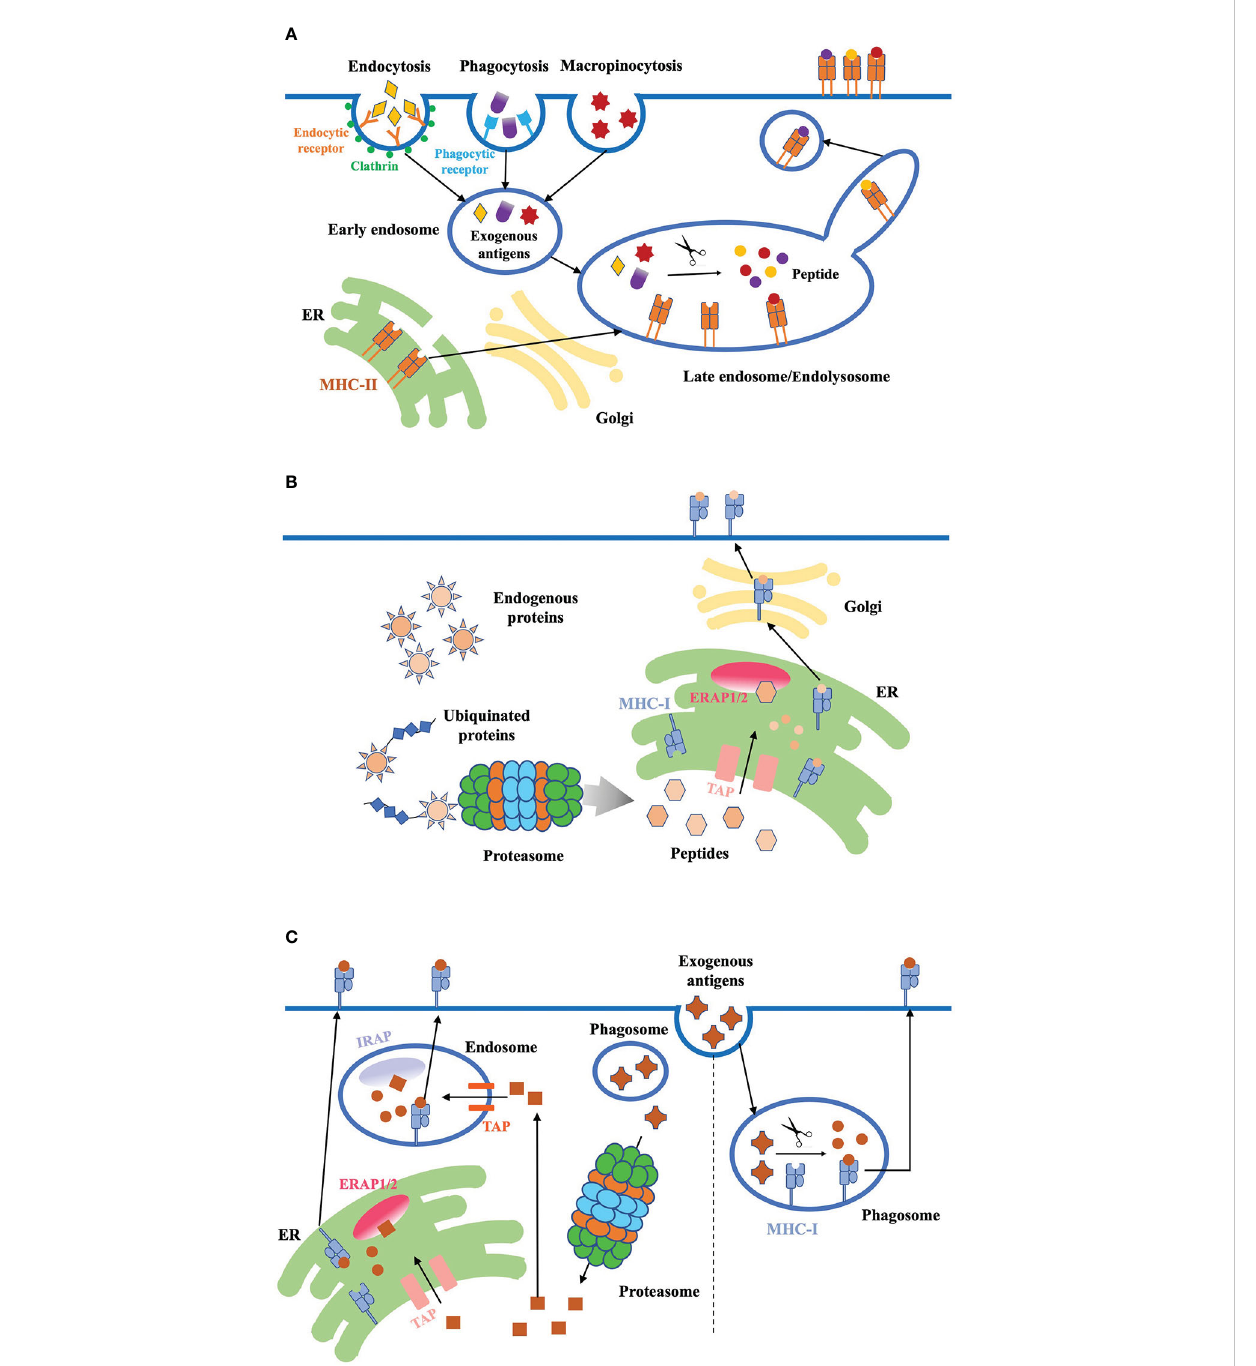
FIGURE 2 Antigen internalization, processing and presentation. (A) Exogenous proteins. DCs use three major ways to internalize exogenous antigens: (1) receptor-mediated endocytosis; (2) phagocytosis; (3) micropinocytosis. Exogenous antigens are delivered from early endosomes to late endosomes/ endolysosomes, where they are degraded into peptides. These high-af fi nity peptides bind to MHC-II molecules, and the peptide-MHC-II complex are transported to the plasma membrane through the tubules and vesicles derived from the endosome. (B) Endogenous proteins. Cytosolic proteins fi rst undergo proteolysis, then the peptides are translocated into the ER through TAP proteins. ERAP1/2 in the ER lumen further digests the peptides to fi t the MHC-I. Finally, peptide-MHC-I complex are transported to the plasma membrane through classical secretion. (C) Antigen cross- presentation. Exogenous antigens can be presented on MHC-I molecules through two pathways: the vacuolar and cytosolic pathway. In the vacuolar pathway, engulfed antigens are digested into peptides in phagosomes, where MHC-I molecules bind to the peptides. In the cytosolic pathway, antigens fi rst enter the cytosol and are degraded into peptides by proteasome. Peptides are transported into endosome or ER through TAP, and further trimmed by IRAP or ERAP, respectively. Trimmed peptides bind to MHC-I and the complex are transported to the plasma